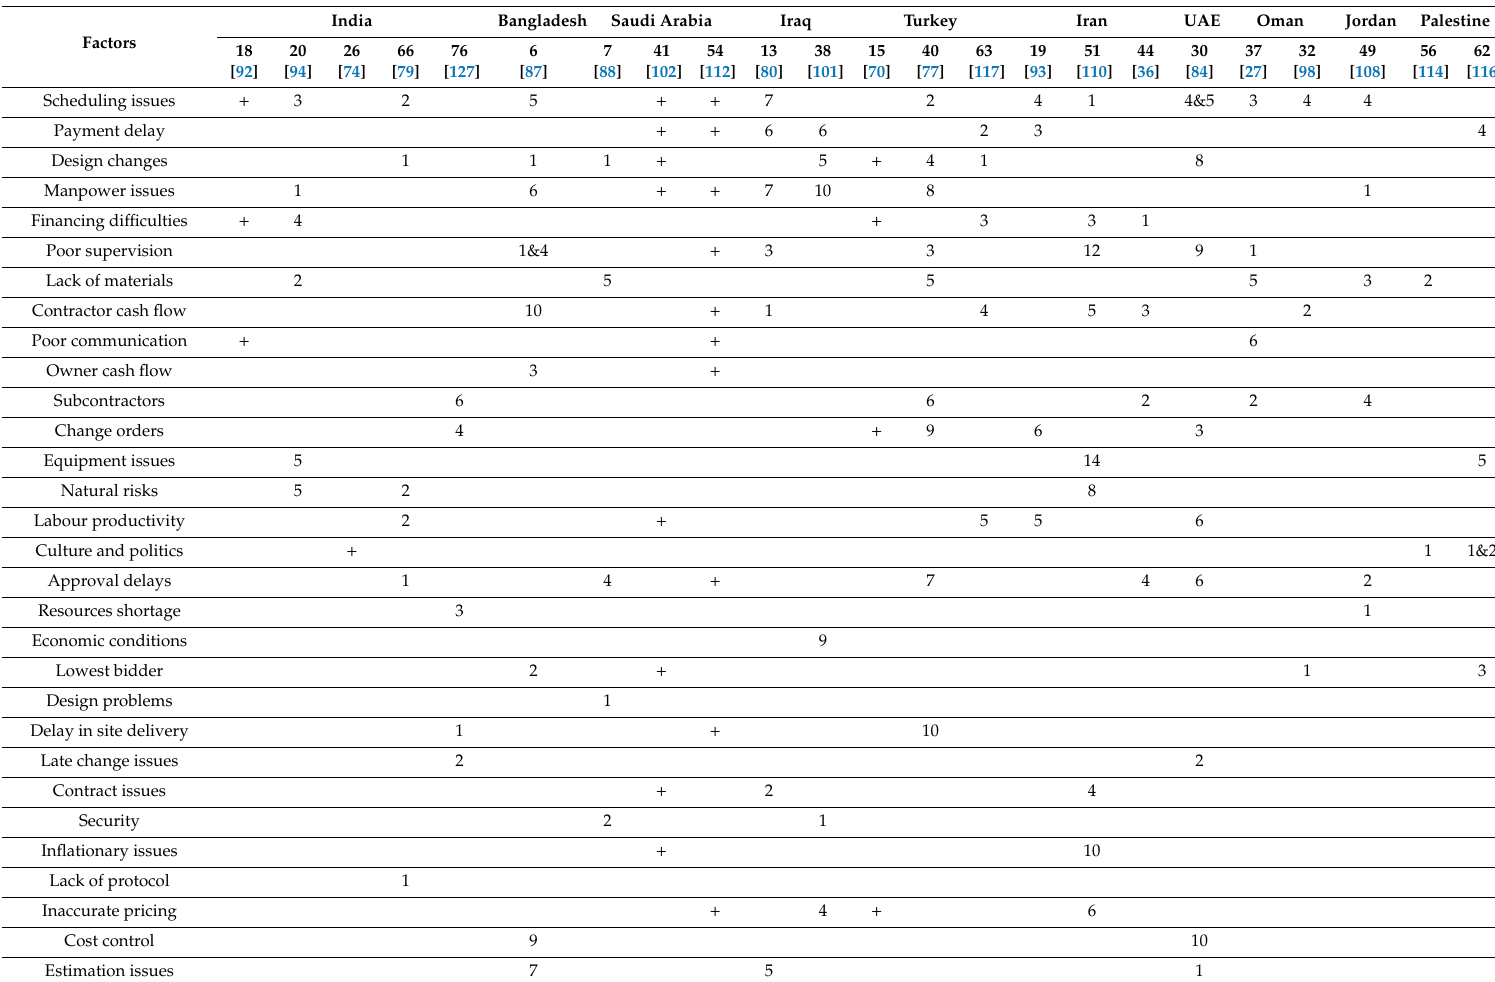
Table 6. Priority list of delay factors within DEC literature for Asian countries, mainly Middle